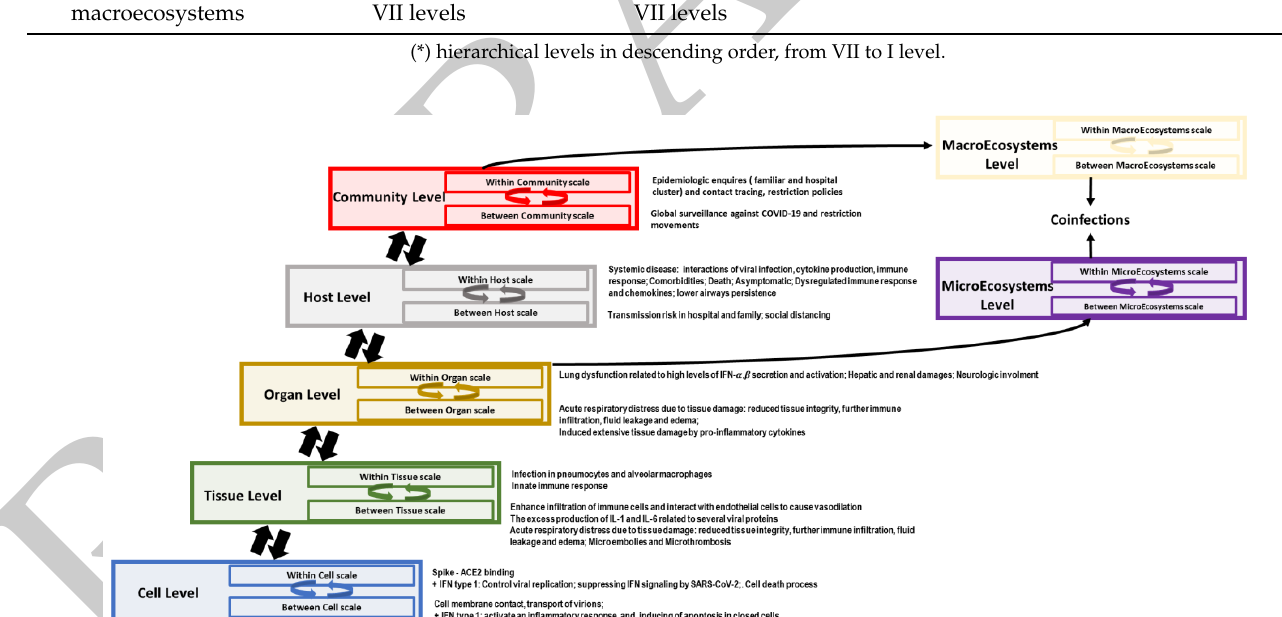
Figure 1. Diagram of seven main hierarchical levels of organization of an infectious disease system applied to COVID-19. For each level, scales were reported, along with biological and pathological mechanisms and epidemiological data.